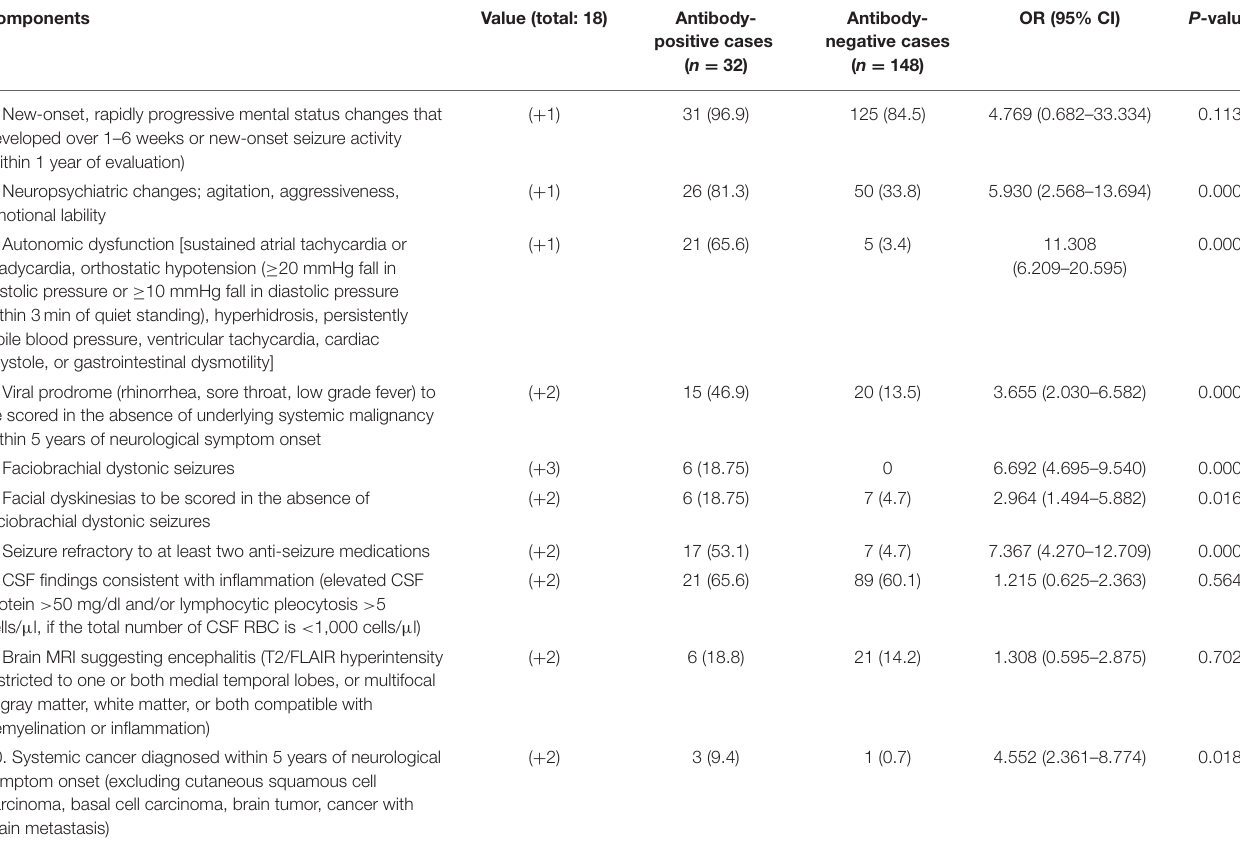
TABLE 2 | Components of the APE 2 score.